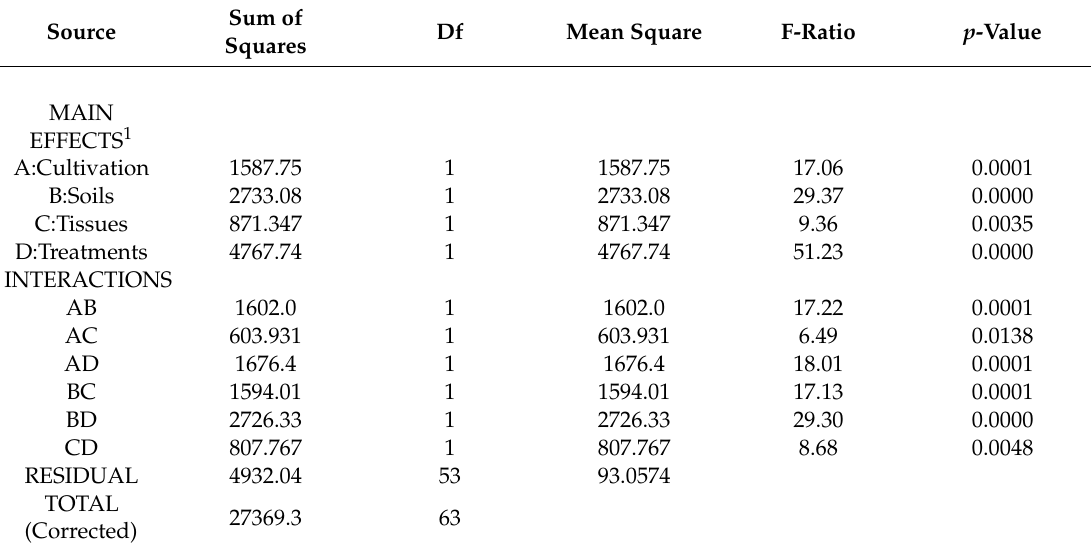
Table 3. Analysis of Variance for e ff ects of various factors on Se